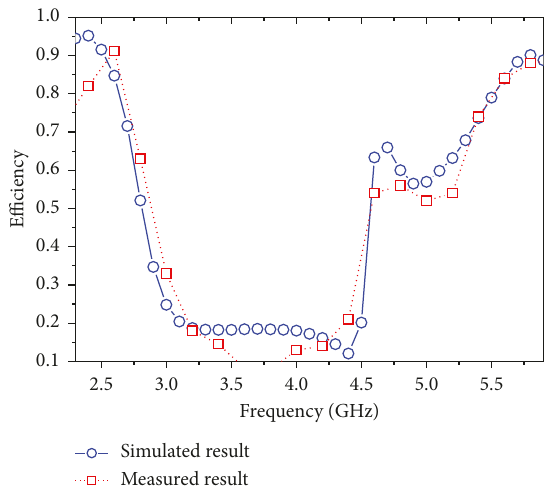
Figure 9: Simulated and the measured efficiency over the operating bands of the proposed directional antenna.